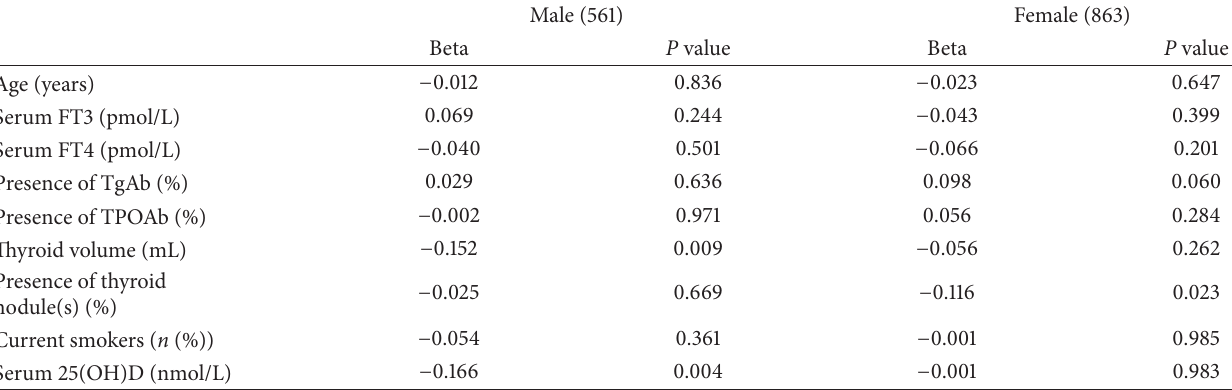
Table 4: Standardized regression coefficients of variables in relation to serum TSH according to gender.